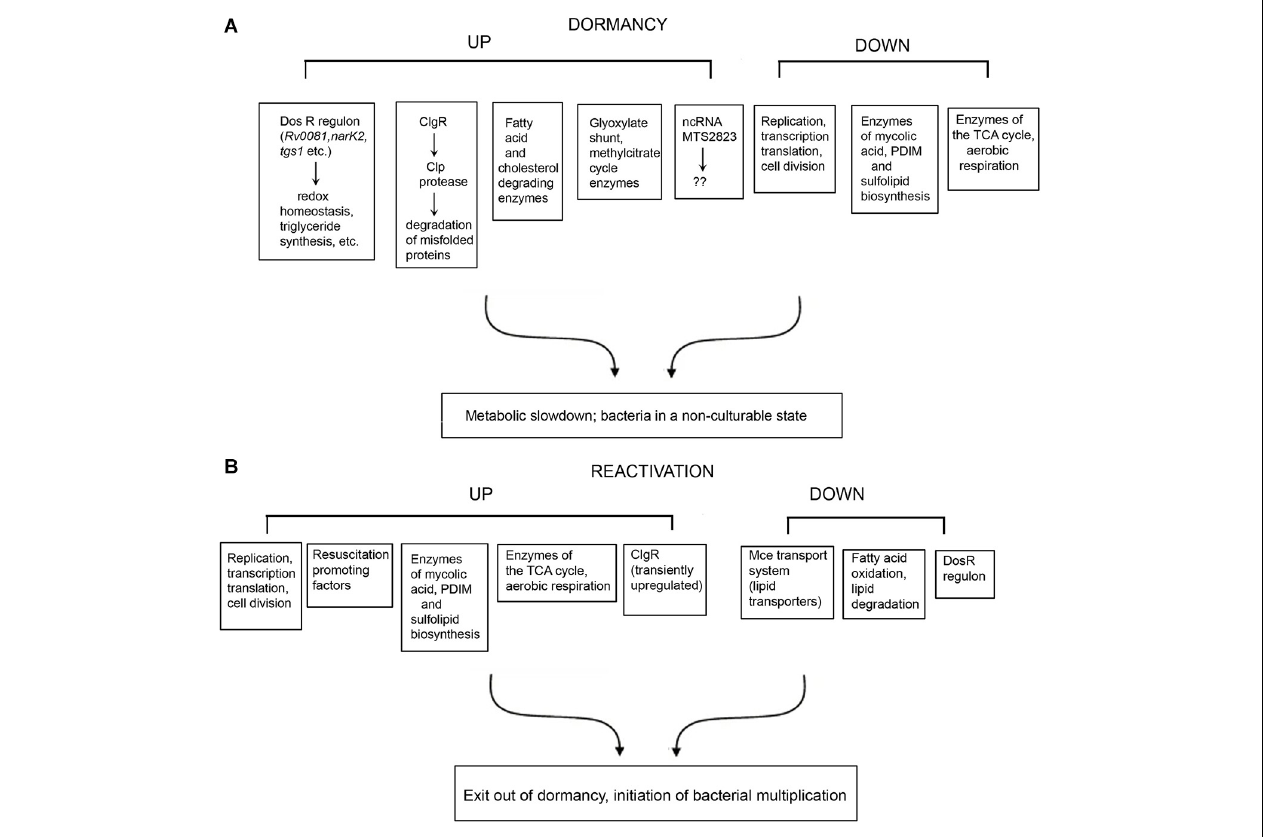
FIGURE 1 | Summary of selected genes, proteins and pathways that are differentially regulated under dormancy (A) and reactivation (B) of Mycobacterium tuberculosis .